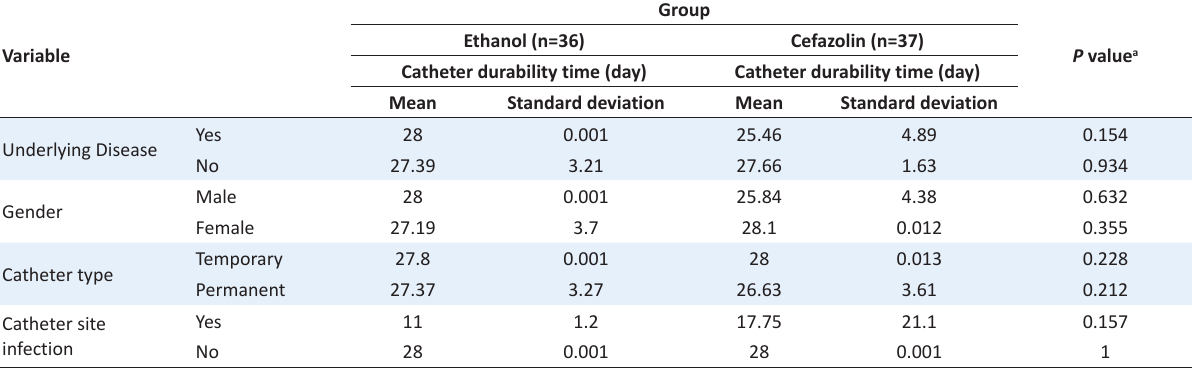
Table 3. Comparison of catheter durability by variables including gender, underlying disease, catheter site infection, and catheter type between two groups of ethanol and cefazolin